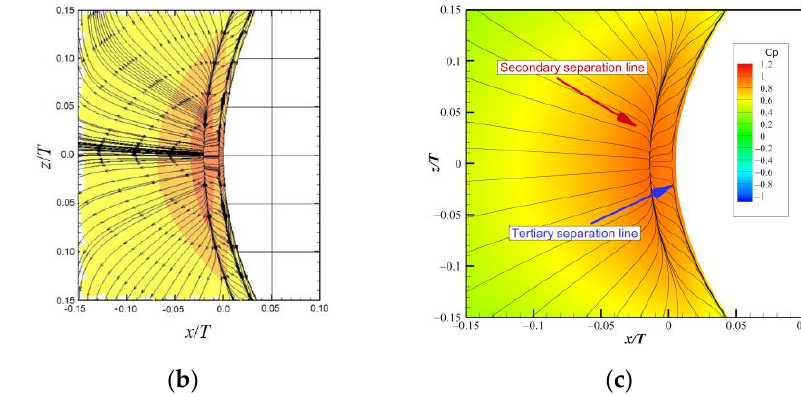
Figure 6. Secondary and tertiary separation lines on the bottom wall: ( a ) RANS/LES [27]; ( b ) wall- resolved LES [31]; ( c ) SLA-IDDES.